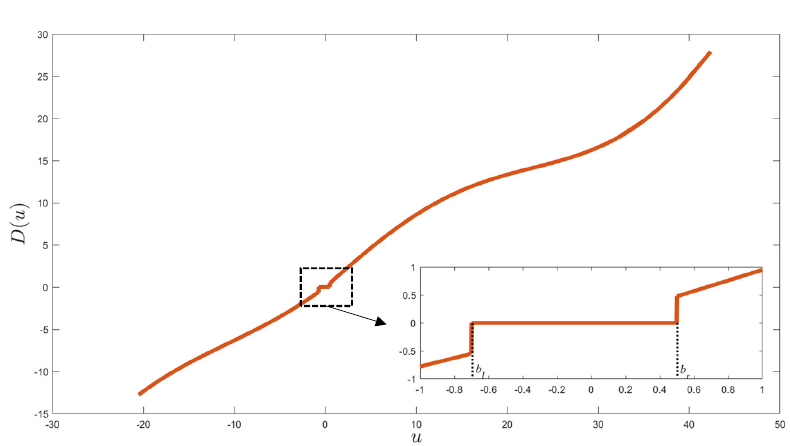
Figure 9. Control input u with dead zone.